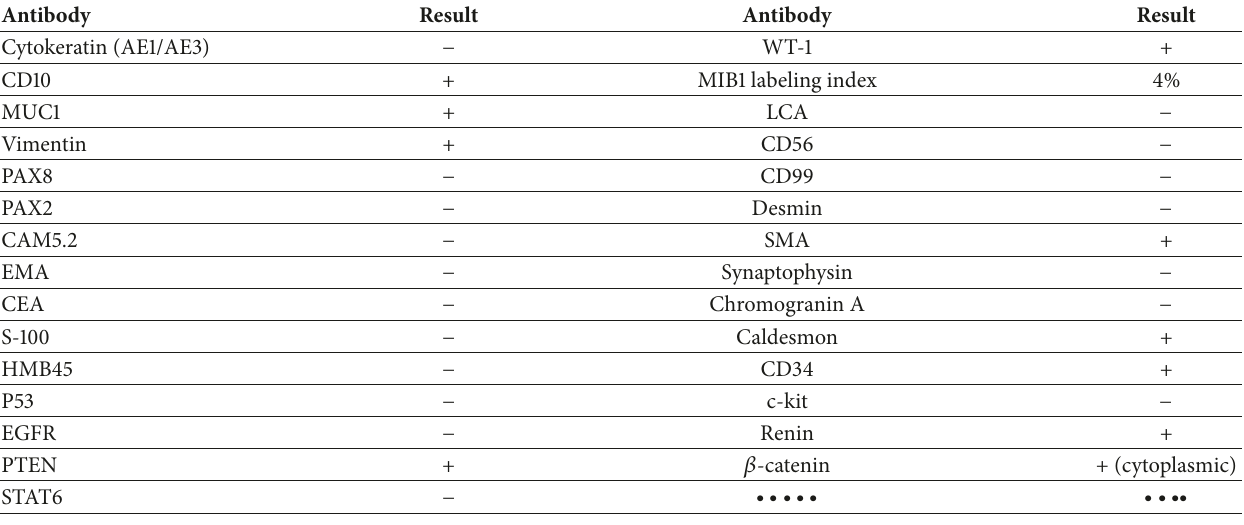
Table 1: Immunohistochemical results.